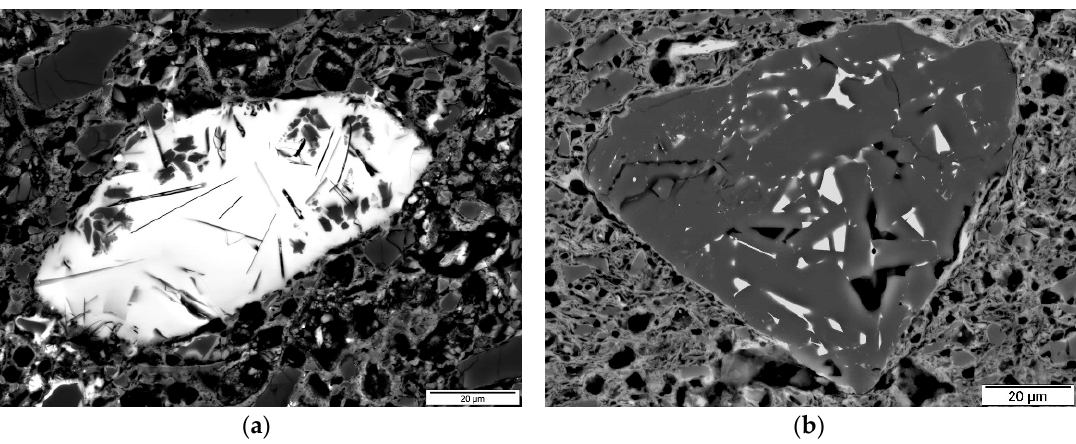
Figure 20. SEM-BSE images of two lead frits [37]. ( a ) Aspect of a grain very rich in lead glass (white) and few SiO 2 phases (grey needles). Note the sharp contact with the matrix. BER 4, Dortu & C ie , Nyon, 1809–1813; ( b ) Aspect of a grain rich in SiO 2 phases with some interstitial PbO-SiO 2 glass. The contact with the body matrix is sharp. CAR 12, Baylon, Carouge, 1822–1827.